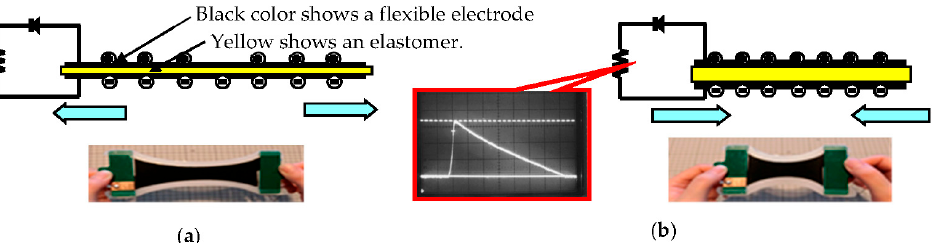
Figure 1. DEG Principle: The middle photo shows a typical oscilloscope trace from a DE contraction. Voltage spikes occur during contraction and gradually return to the voltage of the stretched stage due to load resistance. ( a ) DE extended by external force, ( b ) DE returns to its original shape. The capacitance C of a DE film can be written as